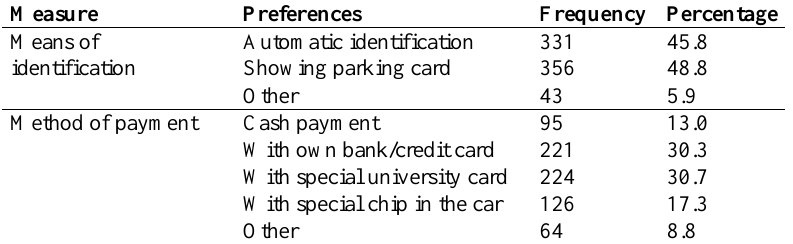
Table 5. Preferences for alternative means of identification and method of payment